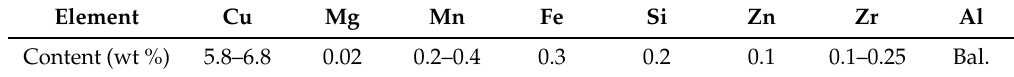
Table 1. The main chemical composition of the 2219 aluminum alloy (wt %).